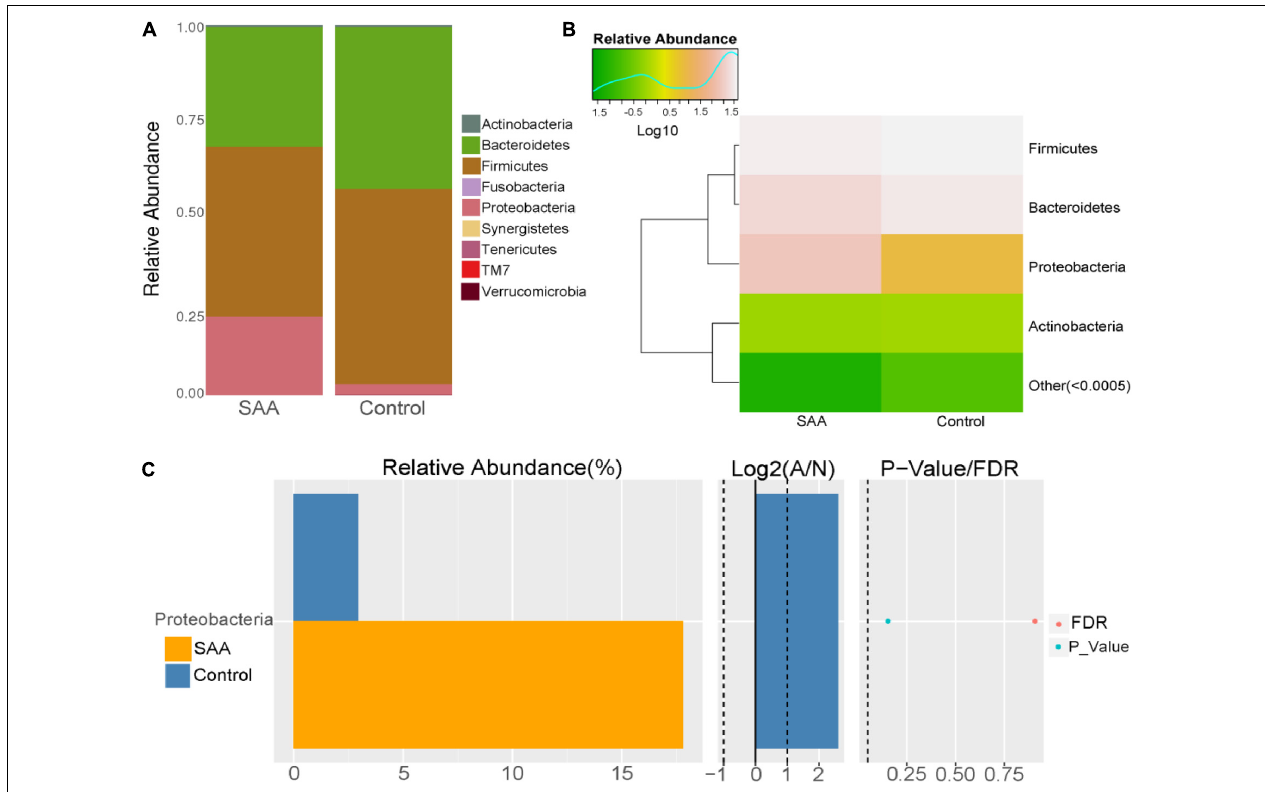
FIGURE 3 | Intestinal microbial compositions of the SAA and control groups at the phylum level. (A) Bar plot, (B) heatmap, (C) Wilcoxon rank-sum test.